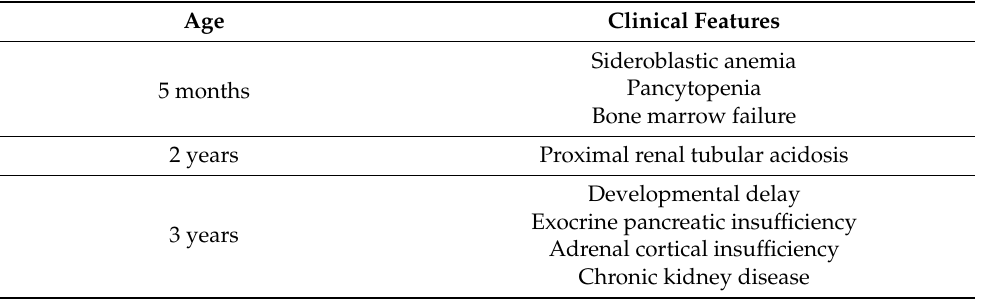
Table 1. Clinical features at different ages of the PS